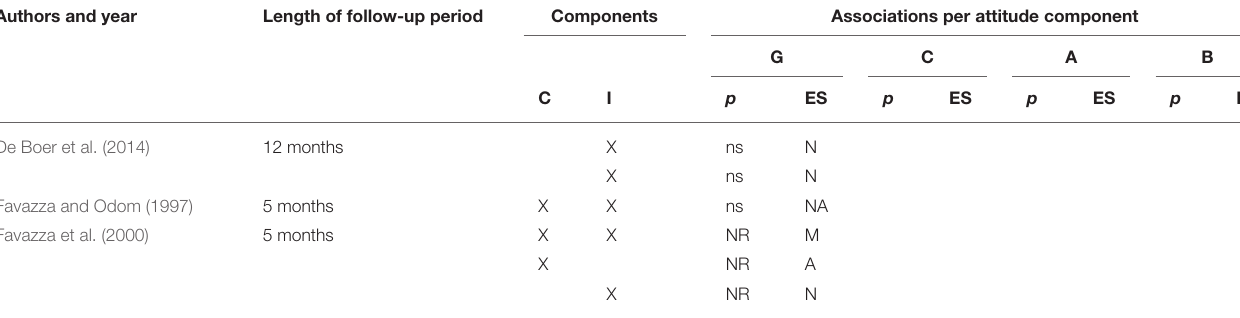
TABLE 5 | Summary of studies examining long-term effects on the attitudes of typically developing peers. Authors and year Length of follow-up period Components Associations per attitude component